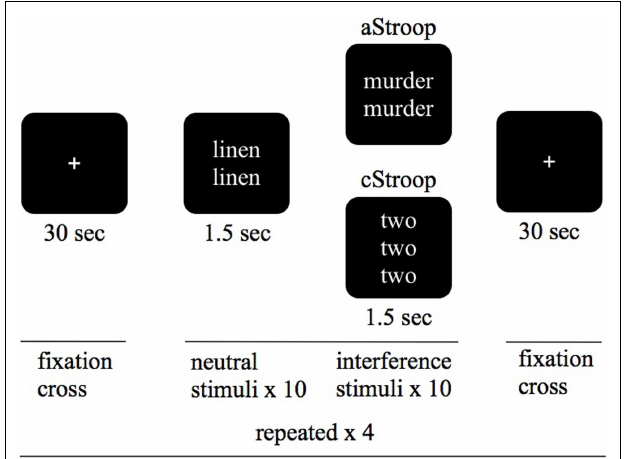
FIGURE 1 | Study design .We used a combined Stroop paradigm: affective counting Stroop (aStroop), and cognitive counting Stroop (cStroop) intertwined.The test subjects were examined in two scanning sessions, the second one 4h after intake of escitalopram (corresponding to C-max). The subjects were blinded to the tablet, and they were instructed that they were to see sets of one to four identical words appearing on the screen and that they should report, via button-press, the number of words in each set, regardless of what the words